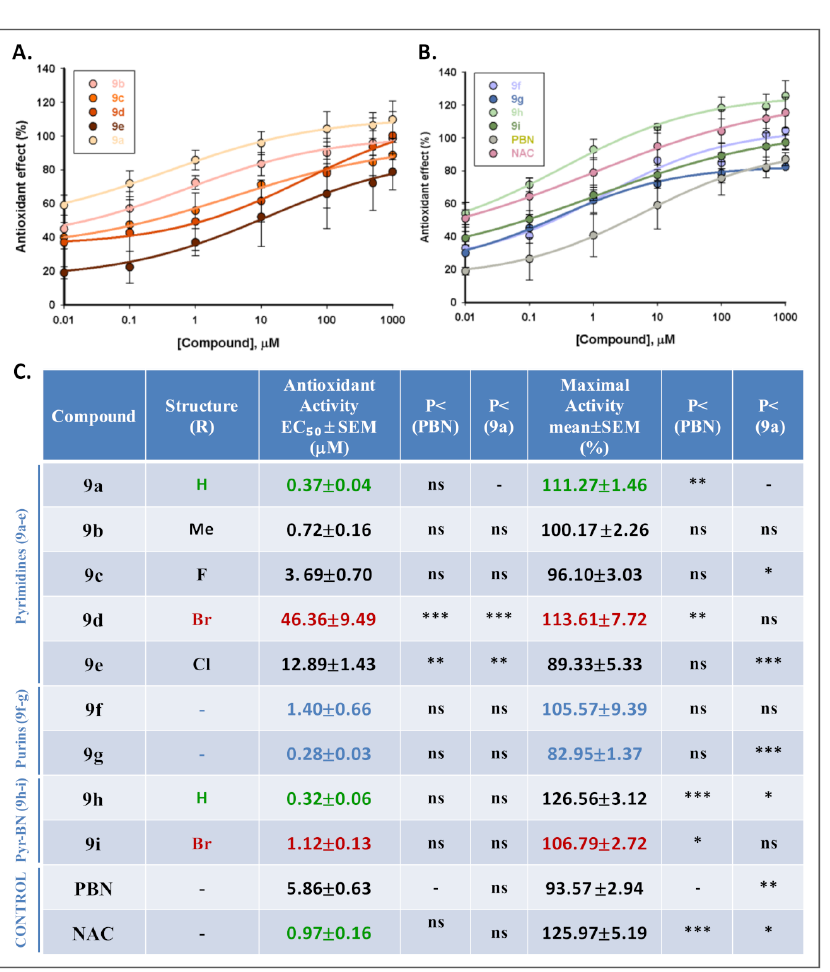
Figure 10. Antioxidant effect of nitrones 9a – i , PBN and NAC after OGDR (IR) in human neurob- lastoma SH-SY5Y cells. ( A , B ) Dose–response curves showing the percentage of antioxidant effect of different compounds at the specified concentrations. ( C ) EC 50 values and maximal antioxidant activities for the indicated compounds. Data representation, curve fitting, and statistical analysis of the data was performed as shown in Figure 4. The statistics compare the differences between EC 50 or maximal activities values for different compounds studied versus PBN or nitrone 9a . * p < 0.05, ** p < 0.01, and *** p < 0.001; ns—not